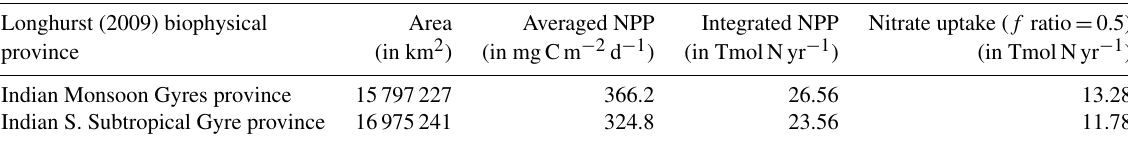
Table 1. Estimated biological productivity and nitrogen uptake in Longhurst (2010) Indian Ocean biophysical provinces. NPP is estimated from satellite data using the Behrenfeld and Falkowski (1997) VGPM. We assume an average f ratio ( f ratio = New P consistent with previous studies of Singh and Ramesh (2015) and Prakash et al. (2015). New P refers to new production.